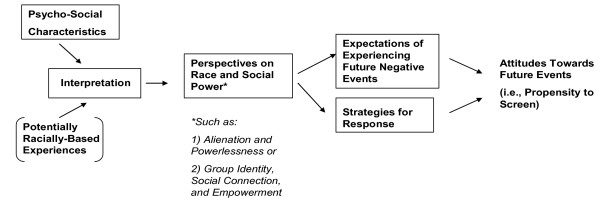
Theoretical Model of the Pathway between Perceived Racial Discrimination and Attitudes Towards Breast Cancer Screening. In Figure 1, persons experience events which they may or may not interpret as racially discriminatory, with the interpretation based in part on their own psychosocial characteristics. (The events are enclosed in parenthesis to denote that they are not directly observed or evaluated by others). This interpretation influences the individual's views on society, which shape both the anticipation of future experiences and the individual's planned reactions, and thus motivation to engage in health behaviors such as breast cancer screening.